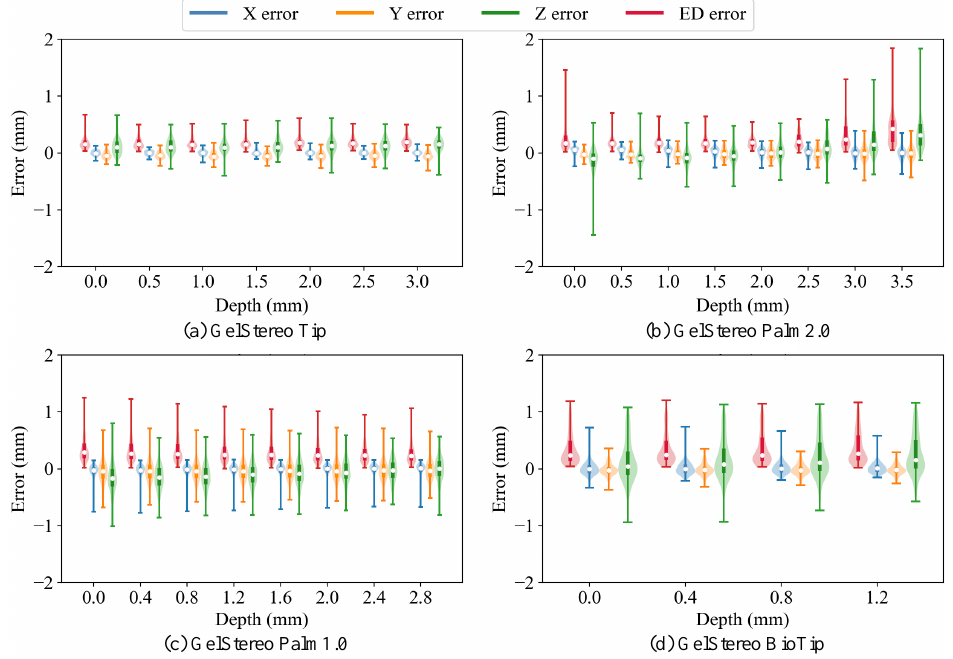
Figure 9. Violin plot showing the distribution of 3D reconstruction errors at different contact depths. The X error, Y error, Z error, and ED error denote the error on the X-axis, Y-axis, Z-axis, and Euclidean distance between the reconstructed 3D points and the ground truth. The white dots indicate